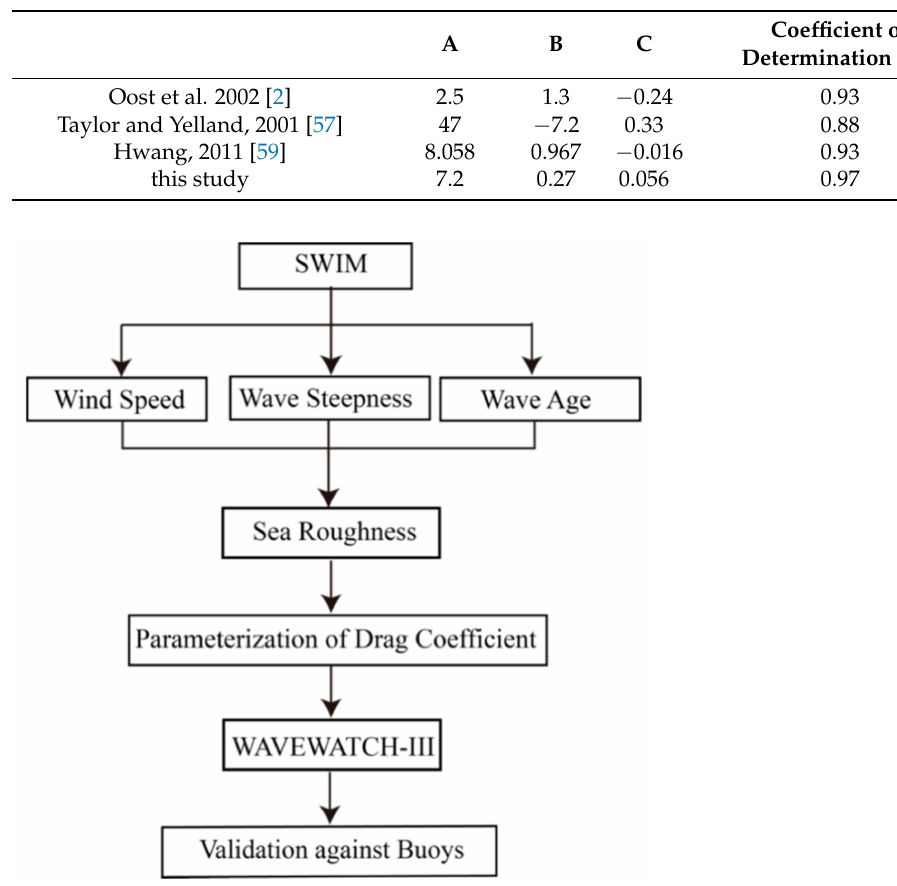
Figure 5. The flowchart of methodology in this study. The experimental data from the southern North Sea at the research platform Meetpost Noordwijk (MPN) were employed for the parameterization of the drag coefficient [2], as well as in [57], utilizing the data at 18 m water depth, based on the remote-sensing data and the parameterization refitted in [59] with the winds below about 15 m/s. Compared with the above data, the wind from the data collection in this study reached 30 m/s, resulting in a high correlation ( R 2 = 0.97) between the observations and